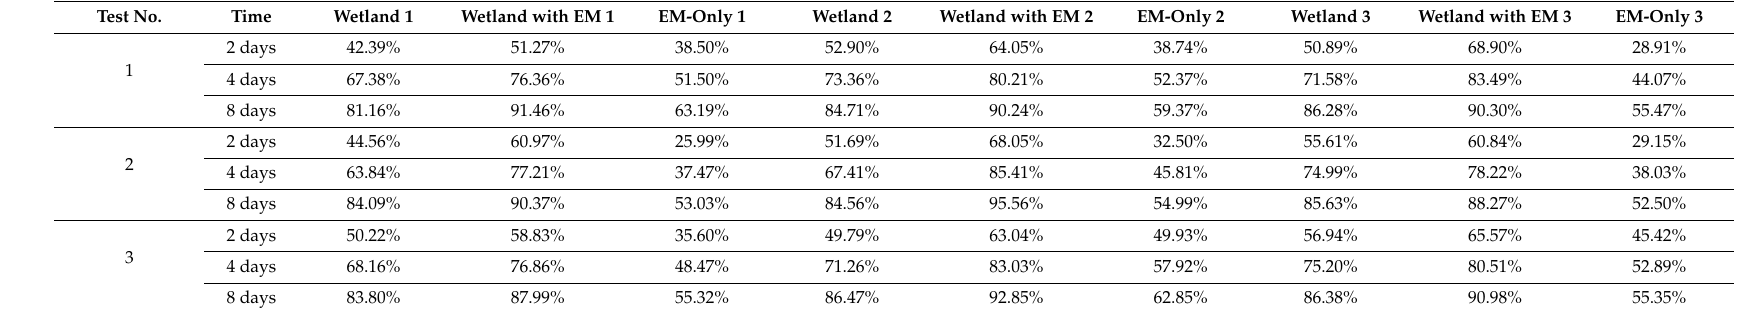
Table 3. NH + -N concentration reduction rates in wetlands over 8 days. 4